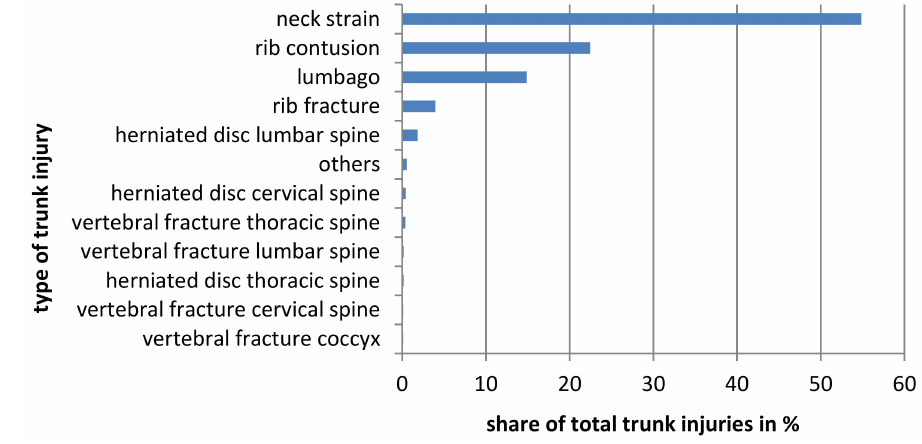
Figure 3. All recorded trunk injuries are shown.